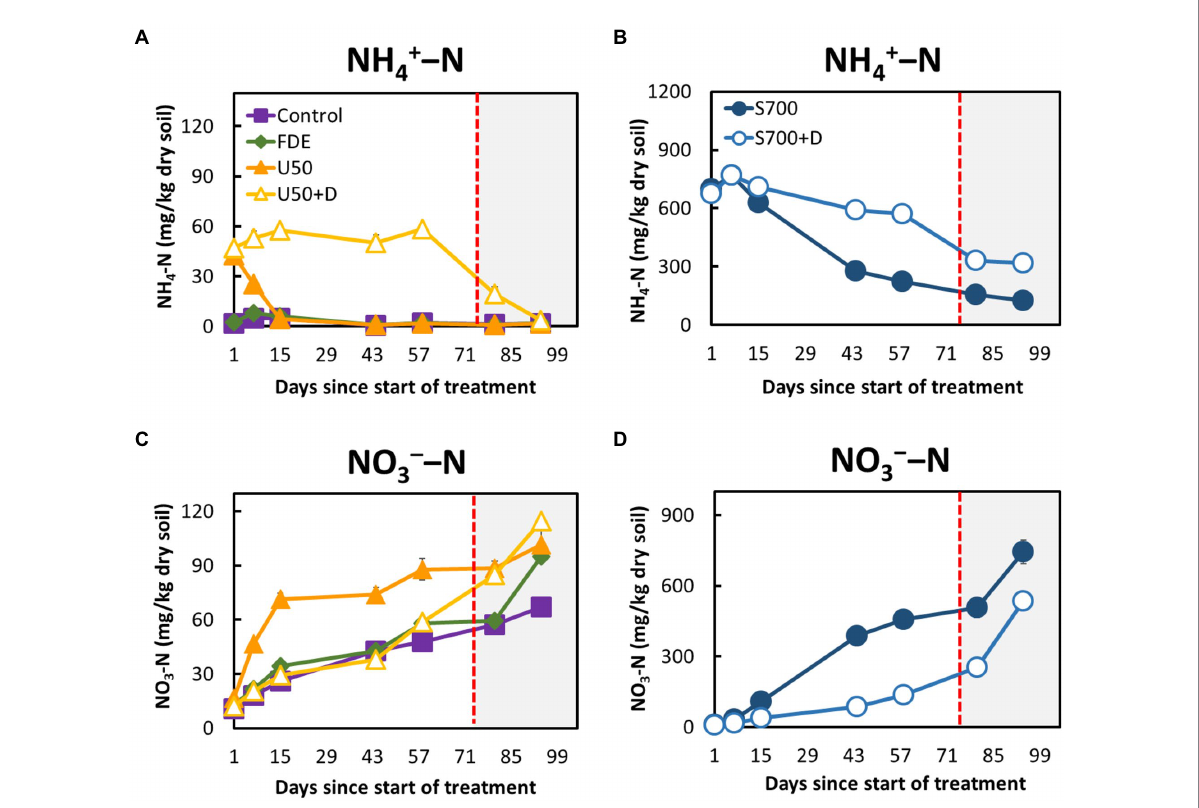
FIGURE 1 Soil ammonium and nitrate dynamics during the 94-day microcosm study. (A) Ammonium–N concentrations in the control, FDE, U50, and U50 + D treatments. (B) Ammonium–N concentrations in the synthetic urine treatments, S700 and S700 + D. (C) Nitrate–N concentrations in the control, FDE, U50, and U50 + D treatments. (D) Nitrate–N concentrations in the synthetic urine treatments (S700 and S700 + D). The unshaded area (Day 1 ─ 72) indicates soil moisture content at approximately 33%, and the shaded area (Day 73 ─ 94) indicates soil moisture content at approximately 42%. Error bars indicate standard errors of the